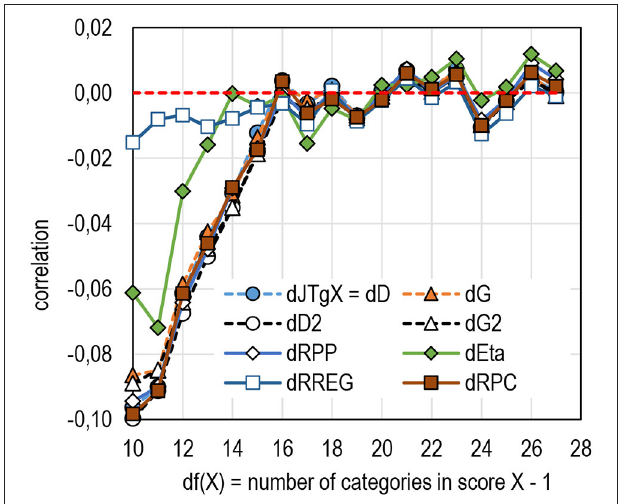
FIGURE 10 | The average difference between the sample and population by the sample size (k =